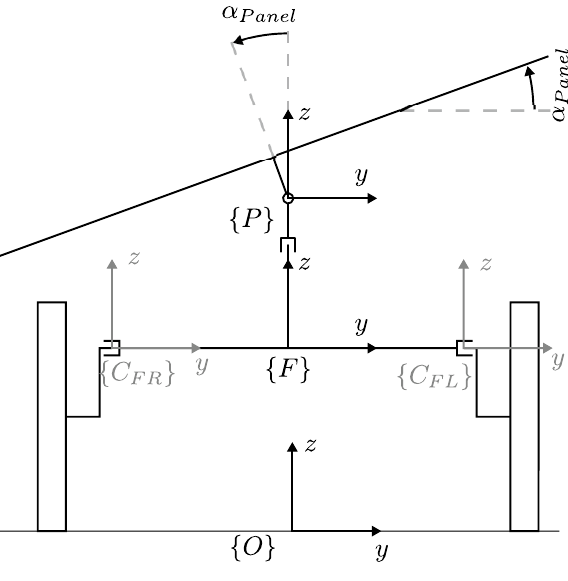
Fig. 4 Functional diagram of Agri.Q PV panels roll